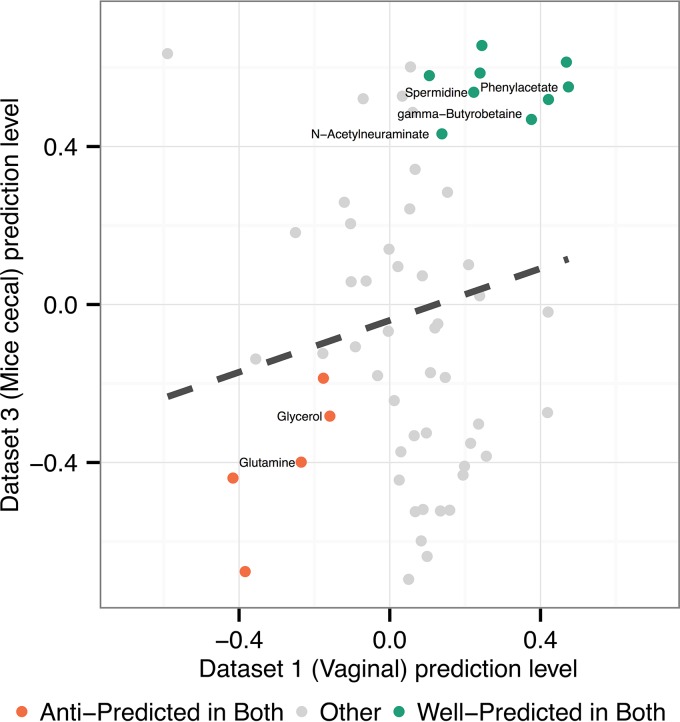
Metabolite predictability is consistent between vaginal and mouse cecal data sets. The plot shows the relationship between the level of predictability for each metabolite (measured as the Spearman correlation between pairwise differences in calculated CMP scores and pairwise differences in measured metabolite abundances) in data set 1 (human vaginal microbiome samples) and data set 3 (mouse gut samples). Colors indicate metabolites that are well-predicted in both data sets or anti-predicted in both data sets. Metabolites that are well-predicted in both data sets are enriched for amino acid catabolites, including phenylacetate, spermidine, and beta-alanine.